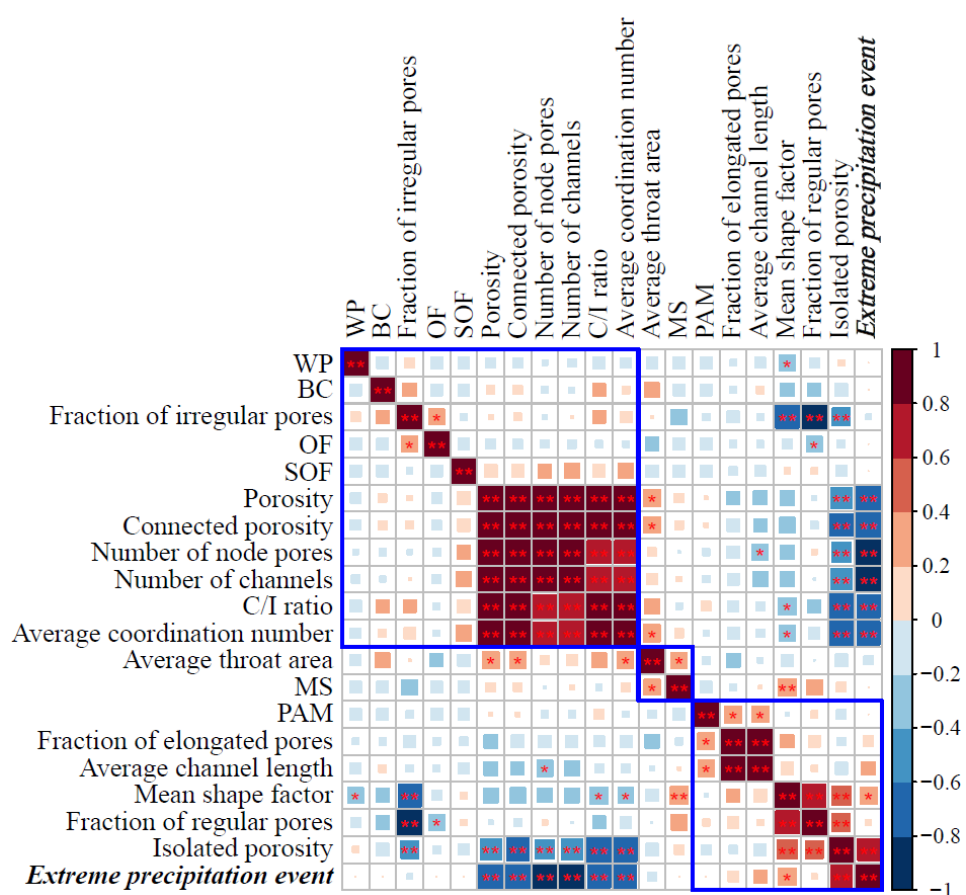
Figure 7. Correlation heatmap analysis for the soil pore characteristics of soils containing organic amendments and extreme precipitation events. The ordering method for the correlation matrix is hierarchical clustering based on Euclidean distance, according to which the parameters are divided into three groups (blue boxes in the figure). * and ** indicate correlation at p = 0.05 and 0.01, respectively. The correlation coefficients range from −1 to 1, with a value between −1 and 0 being negative and between 0 and 1 being positive.